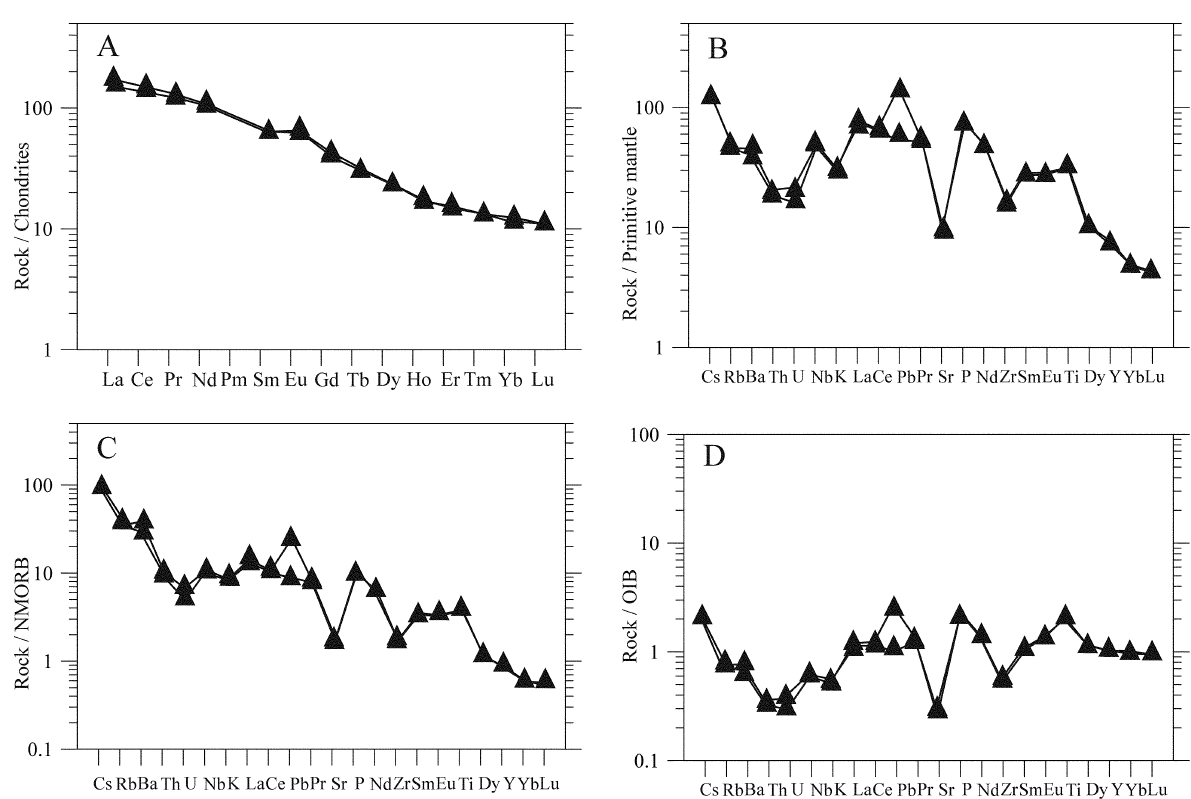
Fig. 7. Abundance of rare earth elements and multi-element diagrams for dolerite from well D1-1. Abbreviations: N-MORB, normal- type mid-ocean ridge basalt; OIB, ocean island